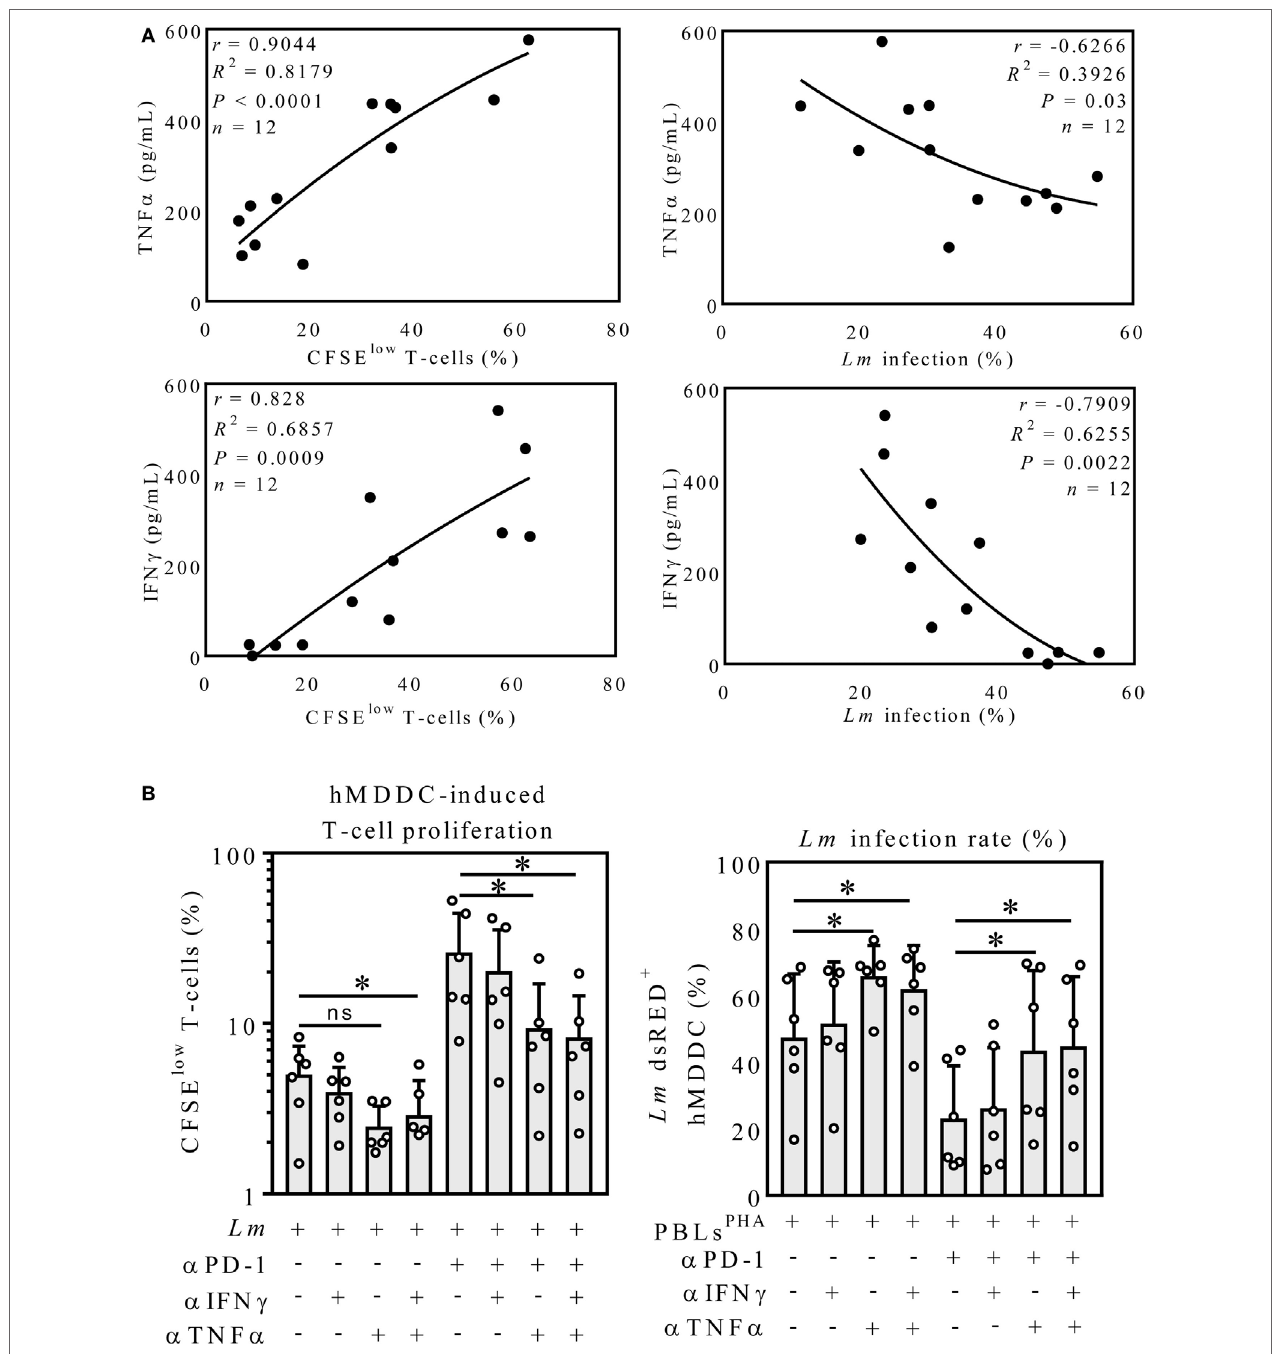
FigUre 3 | Neutralization of TNF α but not IFN γ partially reversed PD-1 blockade-mediated effects. (a) TNF α - and IFN γ -release correlates with T-cell proliferation. All Lm -infected hMDDC samples cocultured with PBL PHA in presence or absence of anti-PD-1 ( α PD-1) were considered (TNF α and IFN γ : n = 12) and Pearson correlation coefficients ( r ), the coefficient of determination ( R 2 ) plus the significance level ( P ) were calculated for the indicated datasets. r ≥ 0.7 = positive correlation; r ≤ − 0.7 = inverse correlation. (B) CFSE-labeled autologous PBLs PHA were cocultivated with Lm -infected hMDDC, nivolumab ( α PD-1), IFN γ neutralizing antibody ( α IFN γ ) and TNF α neutralizing antibody ( α TNF α ) as indicated. After 5 days, cells were harvested and analyzed by flow cytometry (hMDM/hMDDC gated via their FSC/SSC properties, T-cells additionally via CD3). Data are presented as mean percentage of CFSE low proliferating T-cells ± SD or Lm dsRED-infected hMDDC ± SD, respectively. For statistics, a parametric paired t -test was performed, P < 0.05 is considered statistically significant, * P < 0.05, ** P < 0.01. At least three independent experiments were performed ( N = 5–6). hMDDC, human monocyte-derived dendritic cells; Lm , Leishmania major ; PD-1, programmed death-1; PBL, peripheral blood lymphocytes; TNF α , tumor necrosis factor α ; IFN γ , interferon- γ ; CFSE, 5(6)-carboxyfluorescein diacetate N-succinimidyl